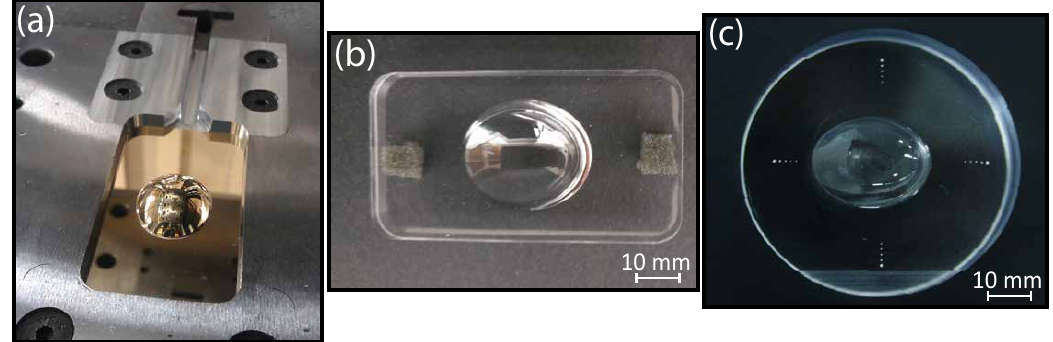
Figure 2. Photographs showing: ( a ) the ultra-precise machined mould used in the injection moulding process (mounted in the injection moulding tool); ( b ) an example injection moulded FPM; ( c ) an example FPM produced by diamond